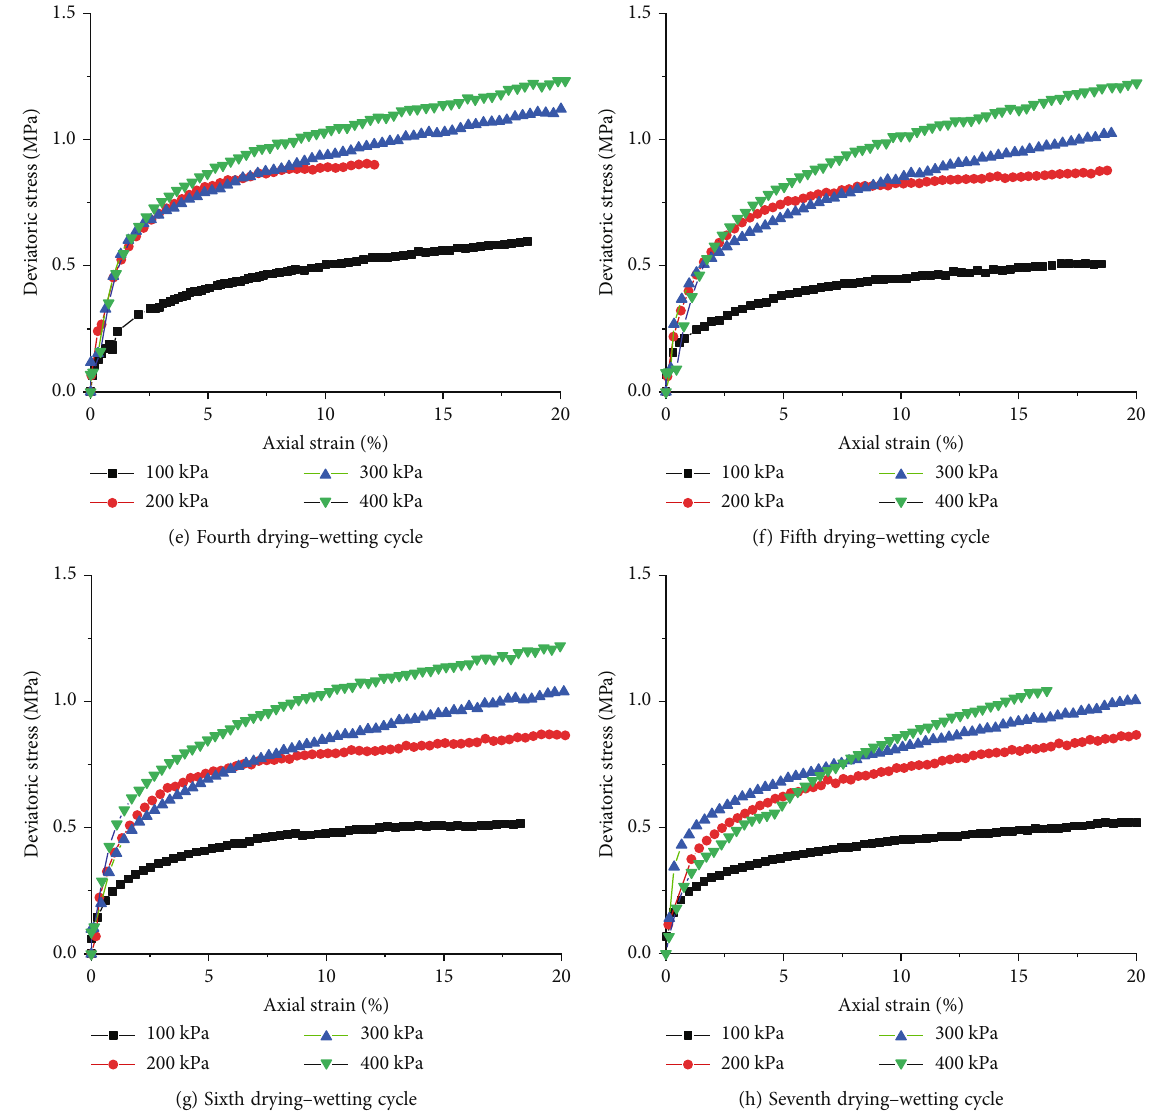
Figure 9: Stress – strain curves following di ff erent numbers of drying – wetting